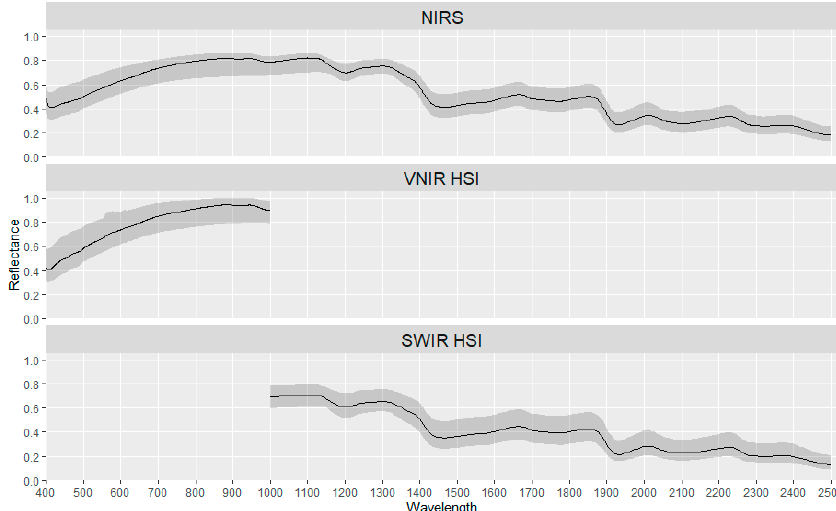
Figure 3. Relative spectral reflectance of the feed samples measured using the near infrared spectroscopy (NIRS, 400–2500 nm) (Top), visible to near infrared hyperspectral imaging (VNIR HSI, 400–1000 nm) (middle) and shortwave infrared HSI (SWIR HSI, 1000–2500 nm) (bottom). Solid line is the average of 69 samples and shading shows the range.